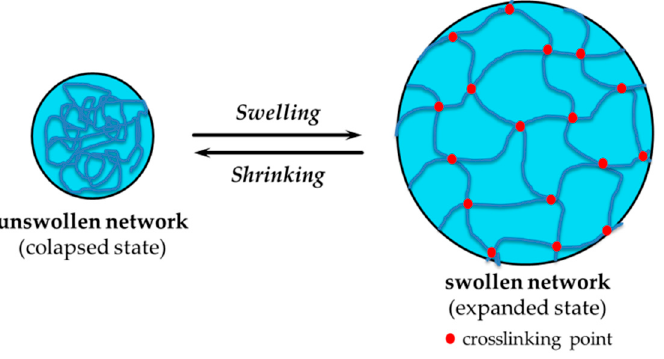
Figure 2. Schematic presentation of hydrogels’swelling in well-defined thermodynamic and hydrodynamic conditions.